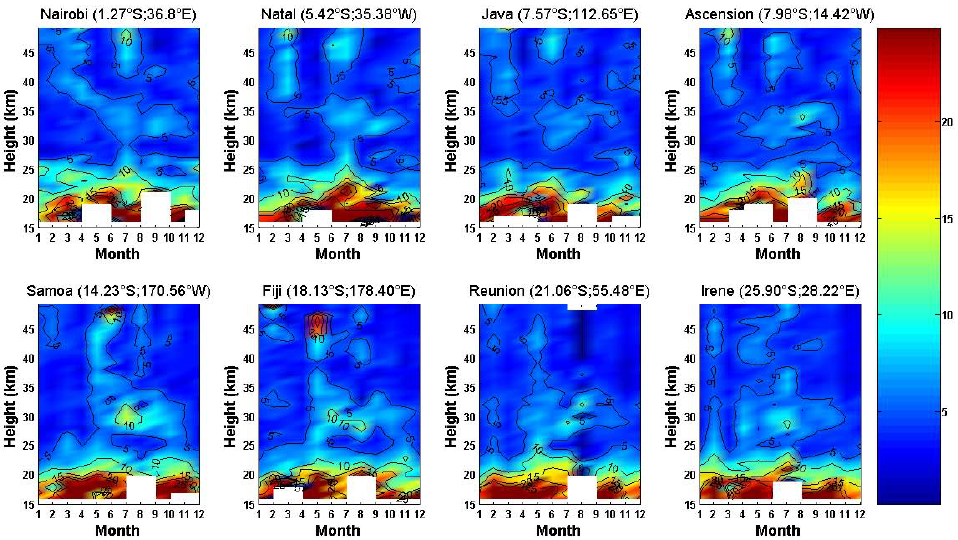
Fig. 4. Contour plots of ozone variability (in %) from GOMOS observations. Variability is defined as the ratio between the interquartile range (iqr) and the median. Contours are separated by